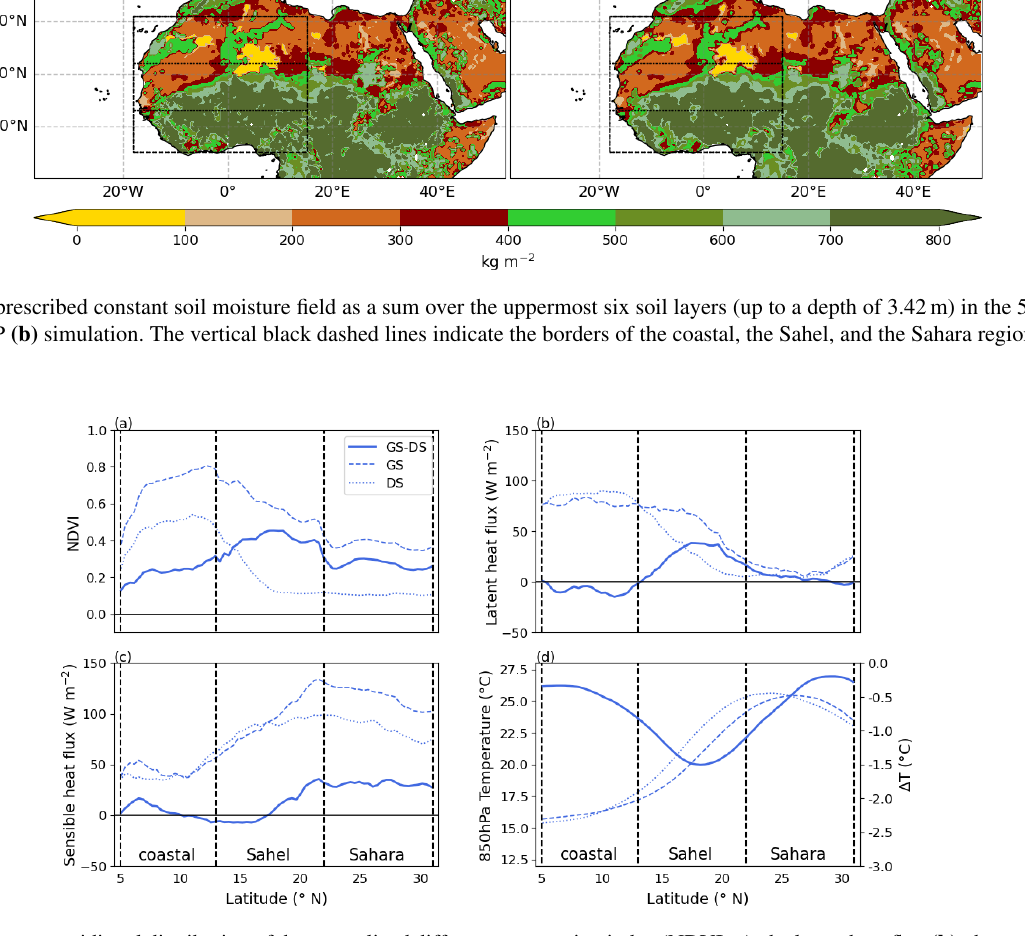
Figure 4. JAS mean meridional distribution of the normalized difference vegetation index (NDVI; a ), the latent heat flux (b) , the sensible heat flux (c) , and the 850hPa temperature (d) for the 5km-E storm-resolving simulations. Note the second y axis in panel (d) for the difference temperature (solid line). The longitudinal mean is taken over the WA domain for the 5km-E simulations. The lines indicate the distribution for the Dry Sahara simulation (DS, blue dotted line), for the Green Sahara simulation (GS, blue dashed line), and the difference between the GS and the DS simulation (blue solid line). The vertical black dashed lines indicate the borders of the coastal, the Sahel, and the Sahara region outlined in Fig.